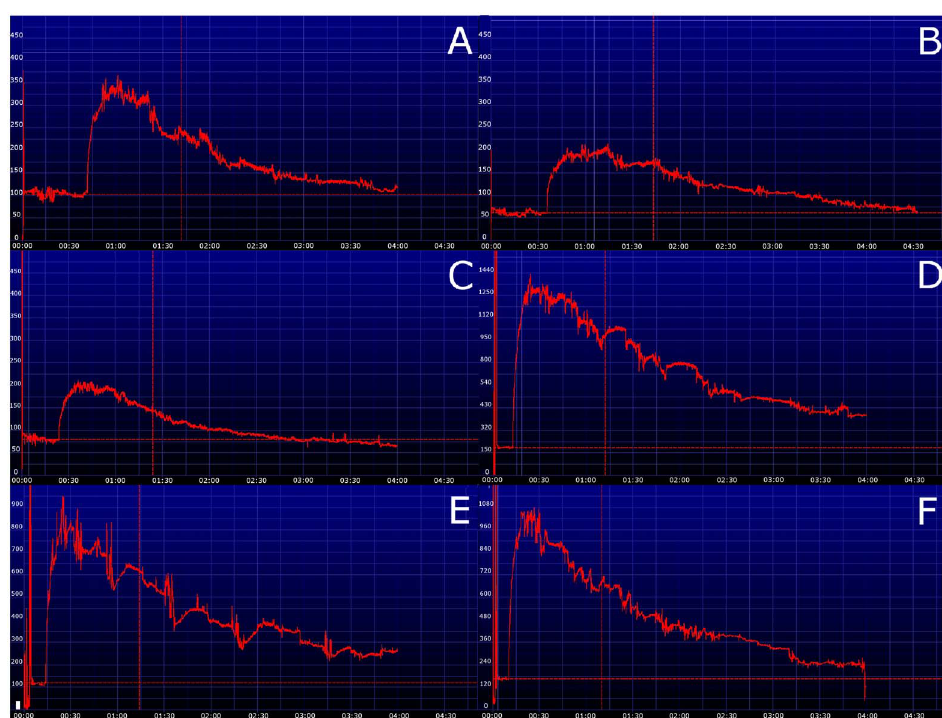
Figure 4. Transcutaneous disappearance curves of fluorescein-isothiocyanate-labelled sinistrin in three dogs (A–C) and three cats (D–F) using a dose of 30 mg/kg.